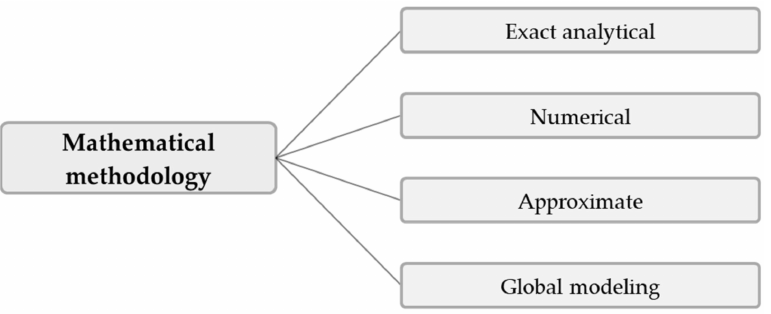
Figure 2. Model categorization B: Classification of melt-conveying models according to the mathe- matical methodology